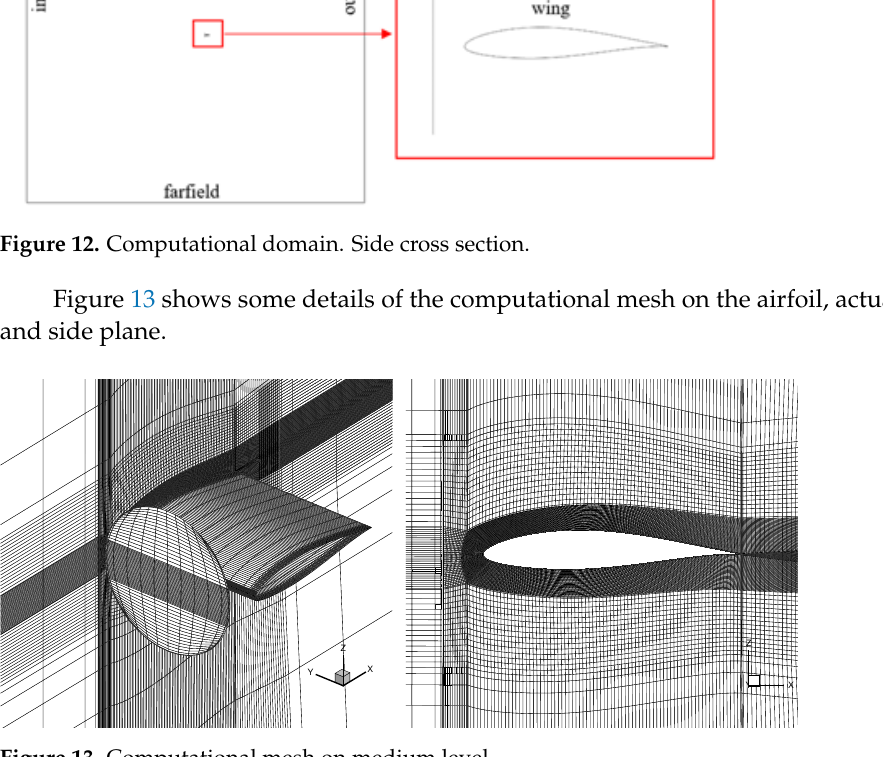
Figure 13. Computational mesh on medium level.